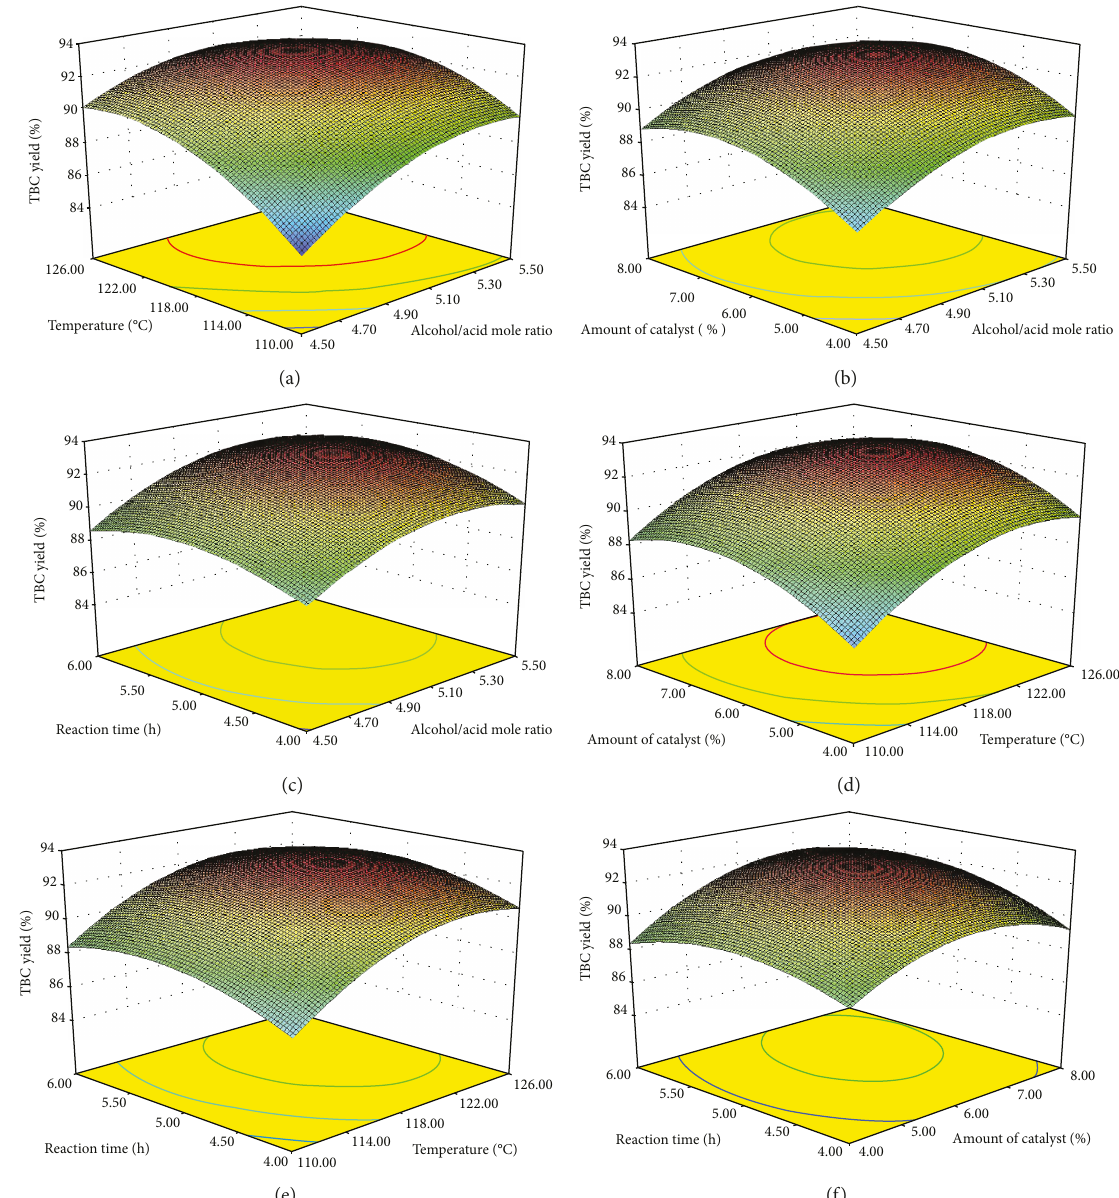
Figure 5: Response surface plots showing the predicted values of the TBC yield: e ff ect of the (a) n-butanol-to-citric acid molar ratio and temperature, (b) n-butanol-to-citric acid molar ratio and amount of catalyst, (c) n-butanol-to-citric acid molar ratio and reaction time, (d) temperature and amount of catalyst, (e) temperature and reaction time, and (f) amount of catalyst and reaction time on the TBC yield. Other variables were kept at their central mole ratio of 5.2 : 1, reaction temperature of 120 ° C, catalyst amount of 6.6 wt%, and reaction time of 5.5 h were selected.